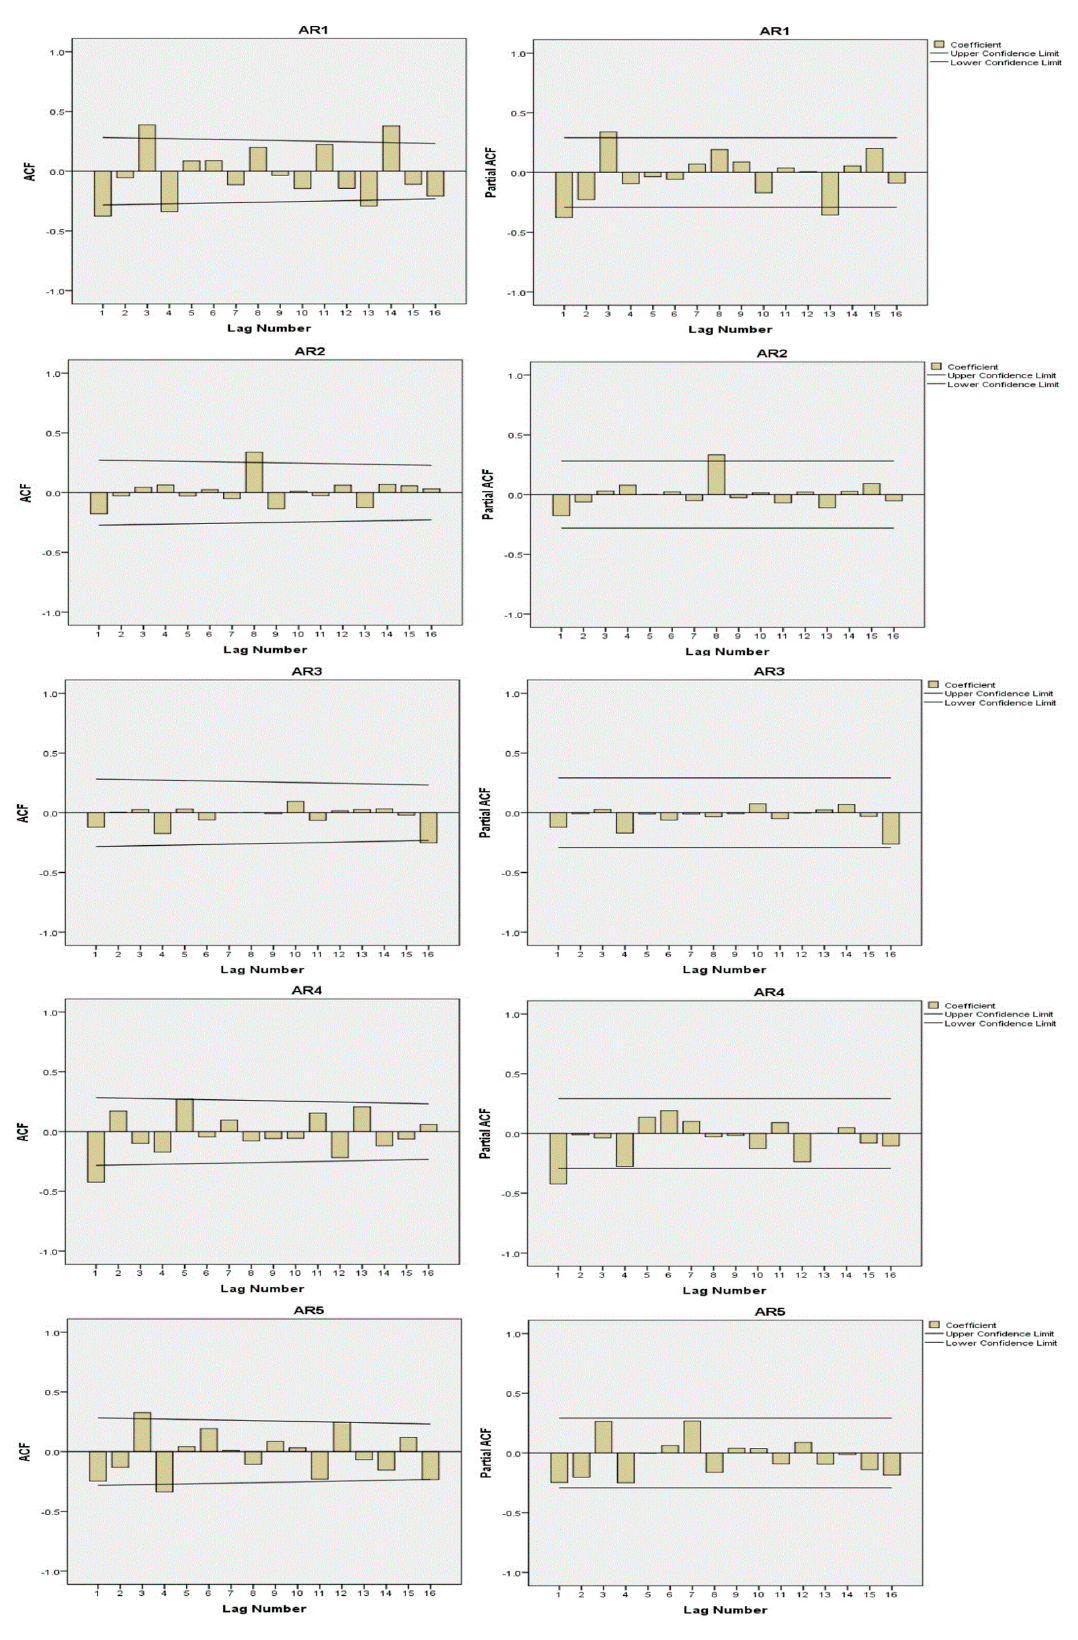
Figure 6. ACFs (left panels) and partial autocorrelation functions (PACFs) (right panels) of the differenced data series.